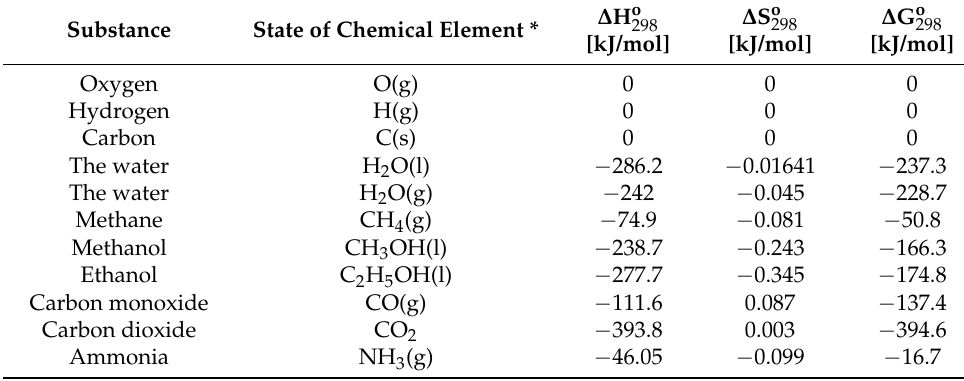
Table 4. Standard values of enthalpy, entropy and free energy